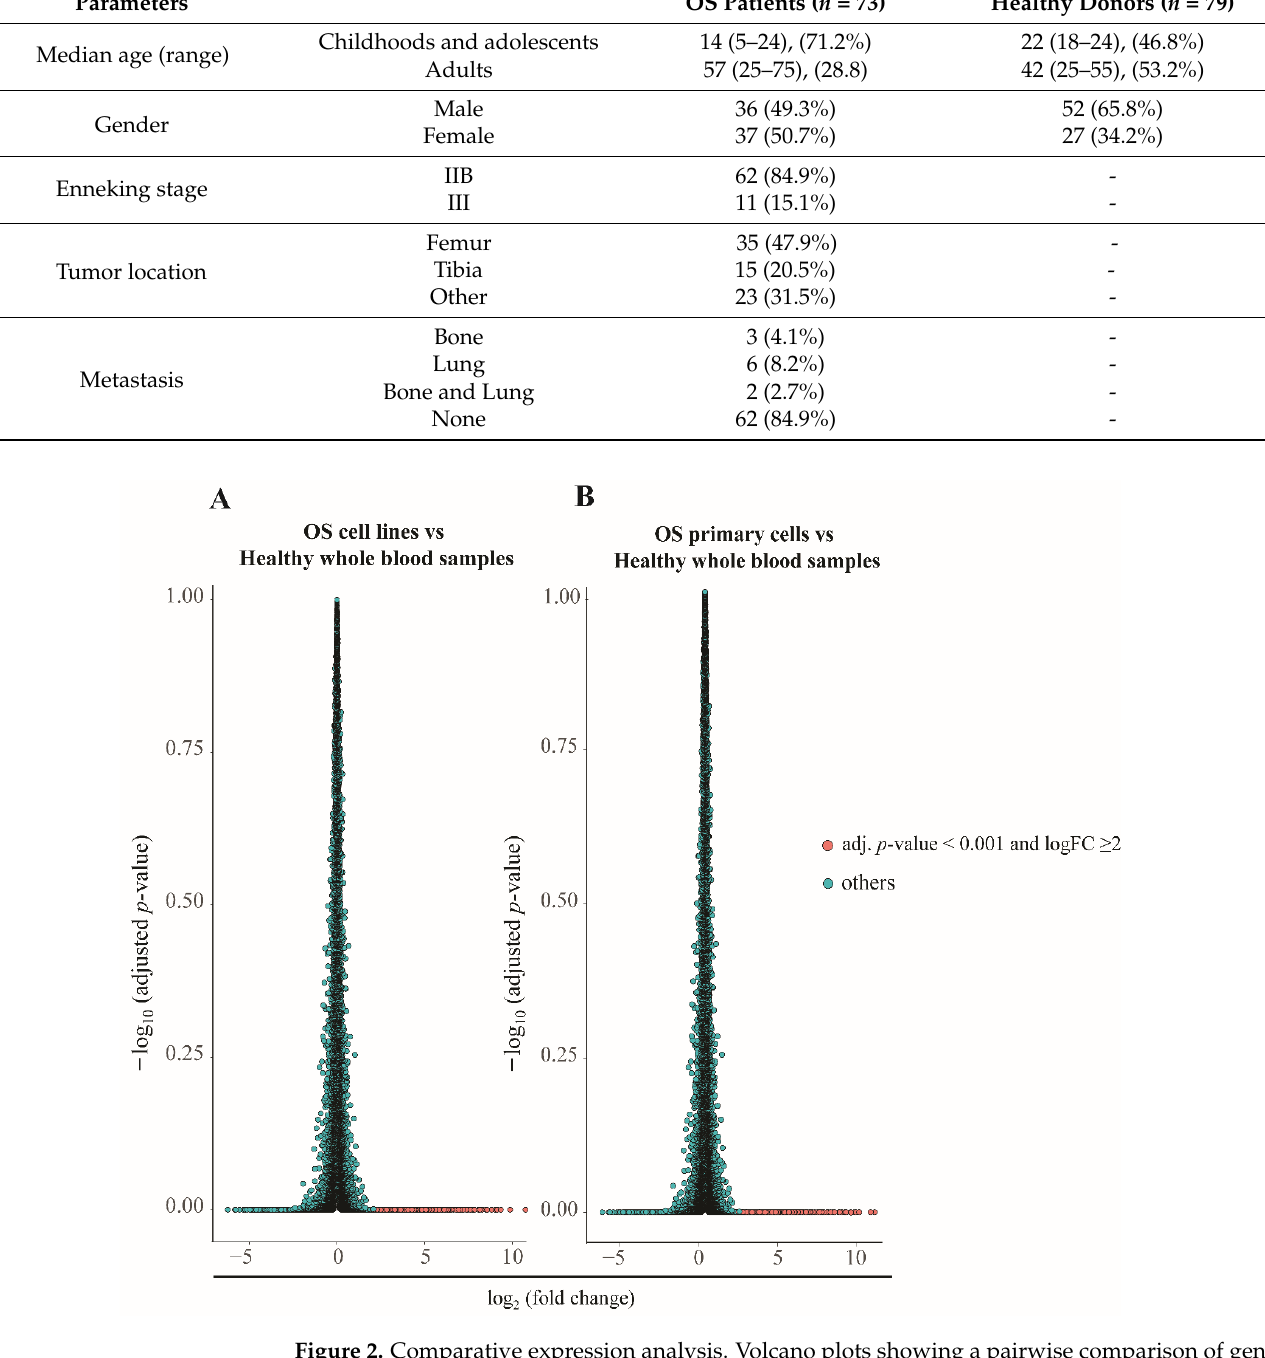
Figure 2. Comparative expression analysis. Volcano plots showing a pairwise comparison of gene expression in osteosarcoma (OS) cells ( A ) and OS primary cells ( B ) vs. healthy donors. The genes presented in red had an expression ratio of > 2 (log 2 ) and adjusted p -value < 0.01.